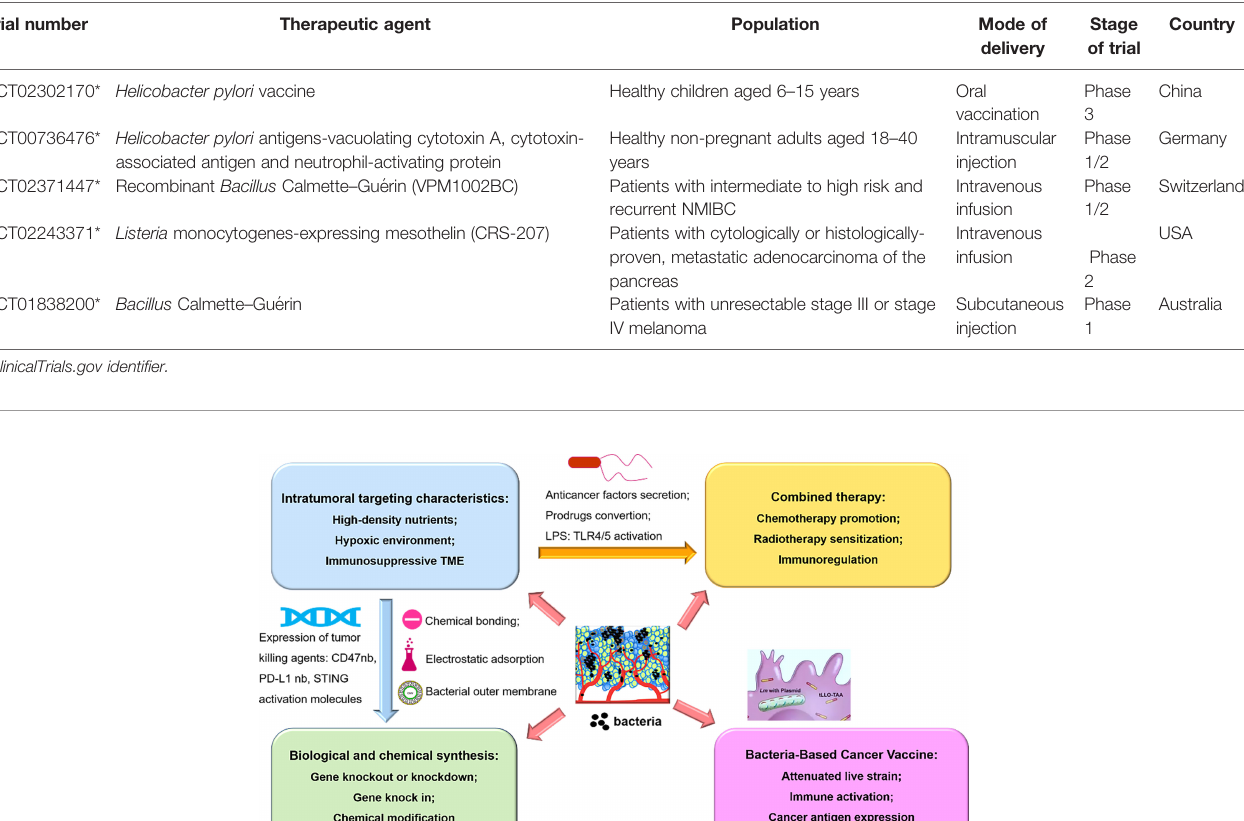
TABLE 3 | Selected clinical trials investigating bacteria and cancer vaccine.